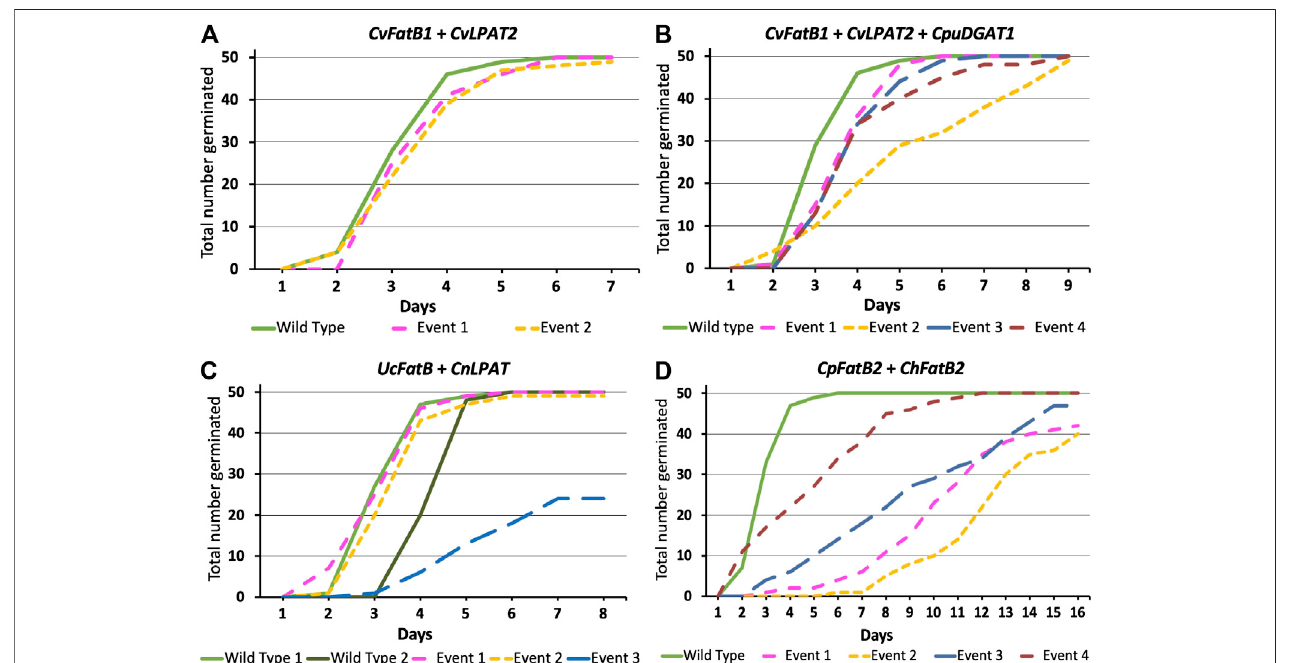
FIGURE 2 | Germination rates of T 3 -generation seeds from each of the MCFA biosynthetic genes combination lines. Genotypes for each panel are as follows: (A) CvFatB1 + CvLPAT2 ; (B) CvFatB1 + CvLPAT2 + CpuDGAT1 ; (C) UcFatB + CnLPAT ; (D) CpFatB2 + ChFatB2 . “ Event ” stands for each linearisingfrom an independent transgenic insertional event. The X -axis represents days from plating surface-sterilized seeds on Murashige and Skoog (MS) salts-containing agar media. Fifty seeds in totalwereplatedforeachline.For UcFatB + CnLPAT (C) ,notethatWildType1plantsweregrownalongsideEvent1and2plantswhereasWildType2plantswere grown in a different chamber alongside Event 3 plants.